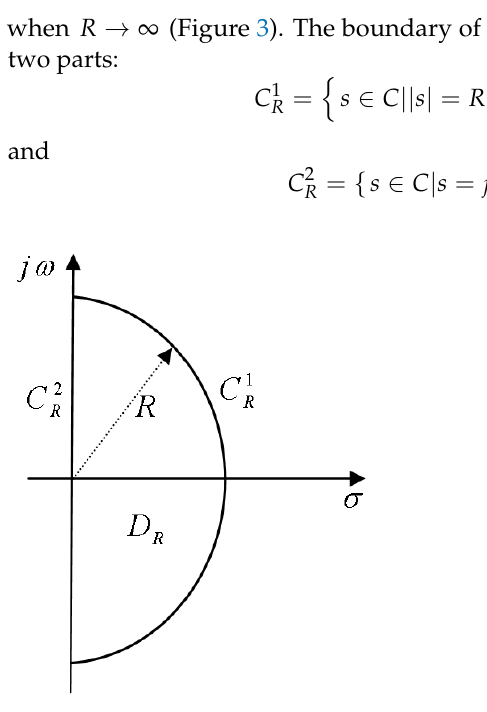
Figure 3. Region R D and its boundary in the complex plane. Figure 3. Region D R and its boundary in the complex